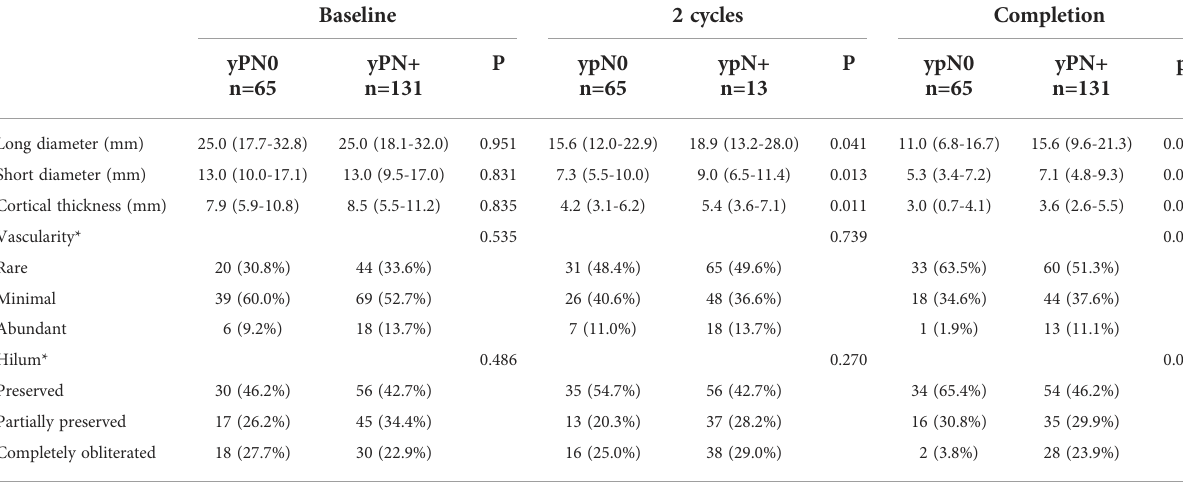
TABLE 2 Ultrasound features of biopsy-con fi rmed metastatic axillary lymph node(s) a of the training set.